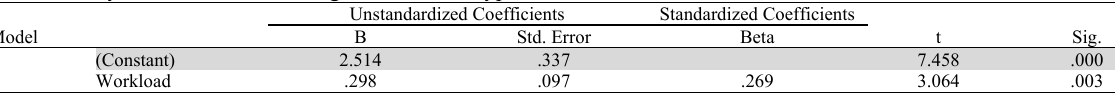
The summary of the results of testing the third sub-hypothesis